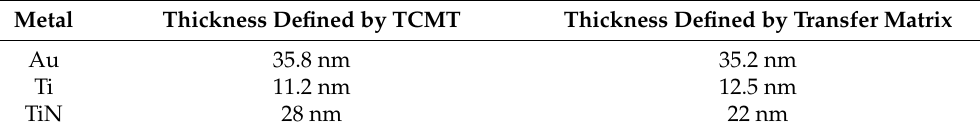
Table 2. Thicknesses of the metal films defined by TCMT and transfer matrix methods.